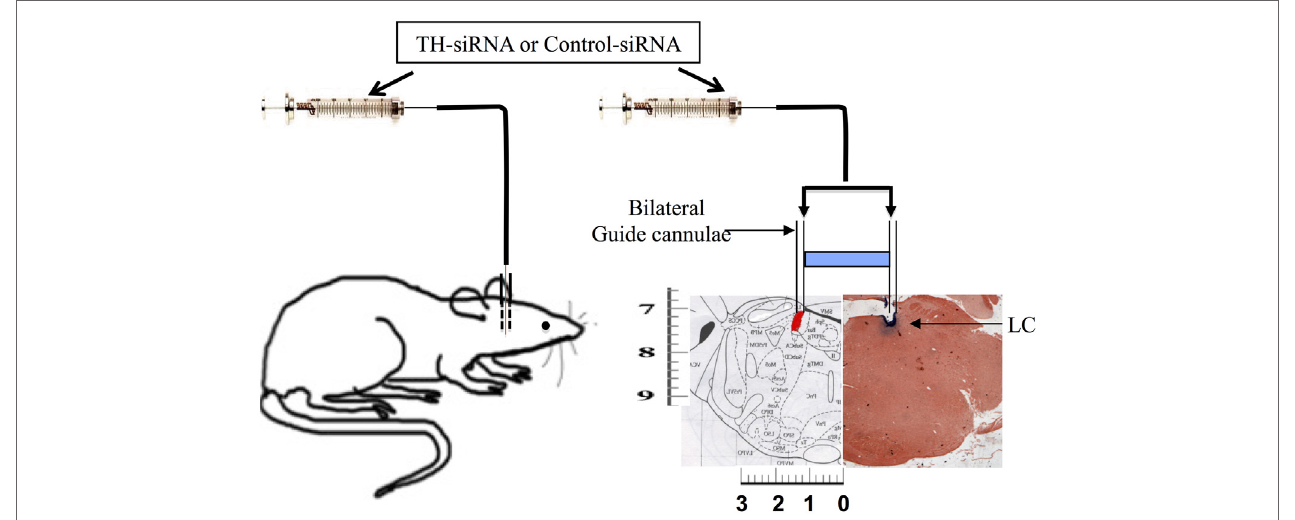
FigUre 1 | schematic representation of microinjection of Th-sirna and control sirna in vivo bilaterally into the lc of freely moving normally behaving surgically prepared chronic rats